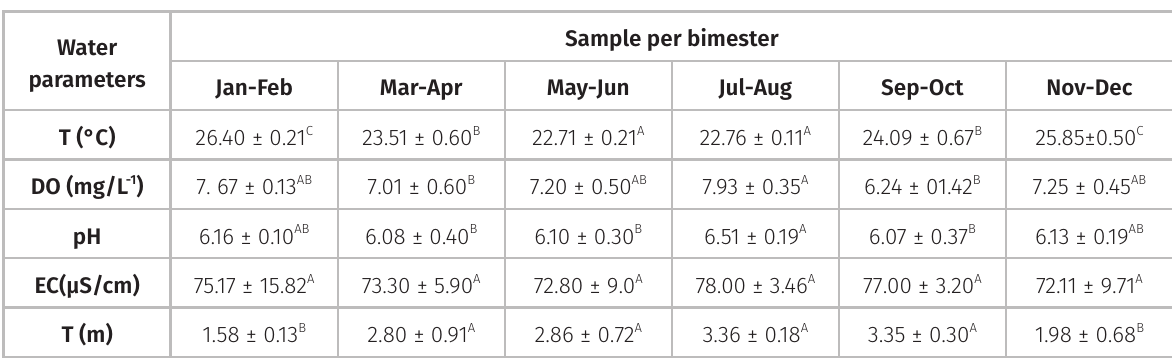
Table I. The bimester values of Temperature (T), dissolved oxygen (DO), pH, electrical conductivity (CE) and transparency (T) between January and December 2012 in the São Francisco River, after the confluence with the Abaeté River, Minas Brazil.